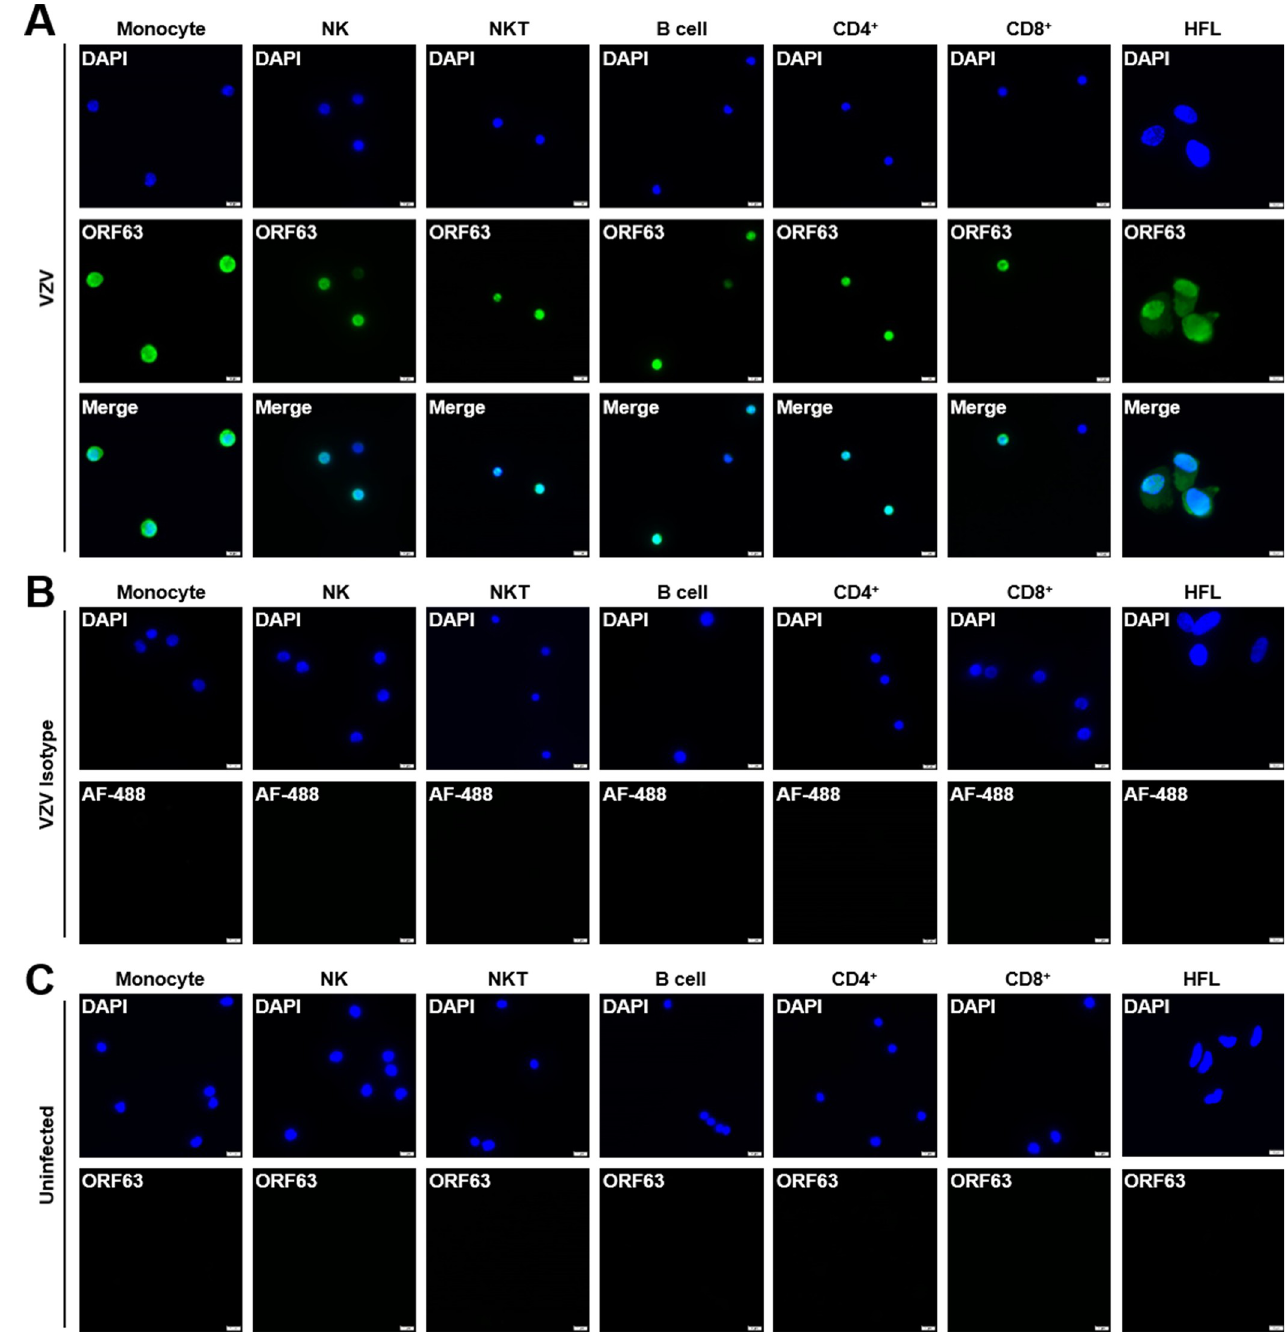
Fig 2. VZV-infected monocytes, NK cells, NKT cells, B cells, CD4 + T cells and CD8 + T cells all express nuclear VZV ORF63. Human PBMCs were co- cultured with uninfected- or VZV-infected HFLs for 48 h, then uninfected- and VZV-infected monocytes, NK, NKT, B cells, CD4 + T and CD8 + T cells based upon surface VZV gE expression were sorted using flow cytometry and analyzed for VZV ORF63 expression using immunofluorescence. Uninfected- and VZV-infected HFLs were analyzed for ORF63 expression as well. (A) VZV-infected monocytes, NK cells, NKT cells, B cells, CD4 + T cells, CD8 + T cells and HFLs all express nuclear VZV ORF63 (green). (B) VZV-infected monocytes, NK cells, NKT cells, B cells, CD4 + T cells, CD8 + T cells and HFLs were stained with Alexa Fluor-488 (AF-488, green) only as an isotype control for ORF63 expression. (C) Uninfected monocytes, NK cells, NKT cells, B cells, CD4 + T cells, CD8 + T cells and HFLs have no VZV ORF63 expression (green). DAPI (blue) was used as cell nucleus stain. Magnification, X400. Size bar = 10 μ m. Results representative of duplicate experiments using PBMCs from 2 different healthy